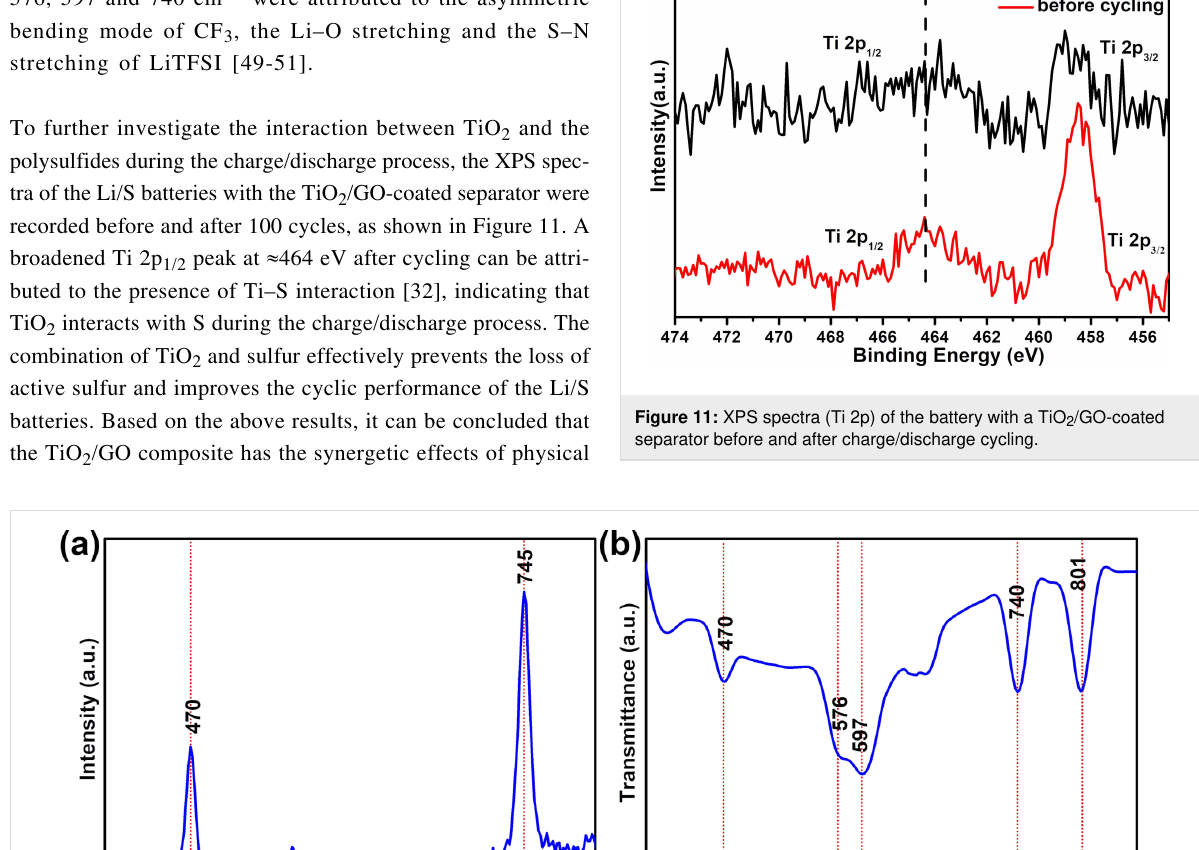
composite is chemically bonded to the polysulfides [48]. The FTIR spectrum of Li 2 S 6 –TiO 2 /GO revealed that the peaks at 576, 597 and 740 cm − 1 were attributed to the asymmetric bending mode of CF 3 , the Li–O stretching and the S–N stretching of LiTFSI [49-51].